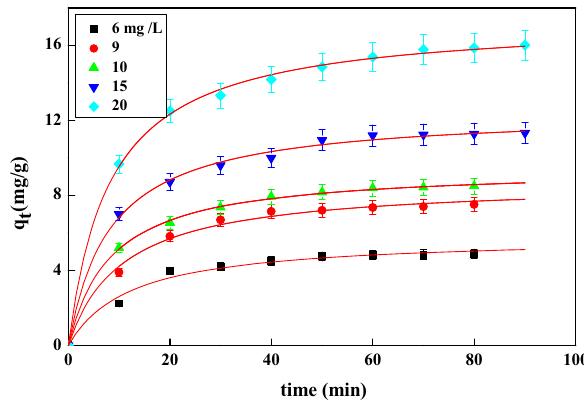
Fig. 2 Biosorption on pre-treated coffee waste at different diazinon concentrations Fig. 3 Diazinon biosorption on pre-treated coffee waste at different